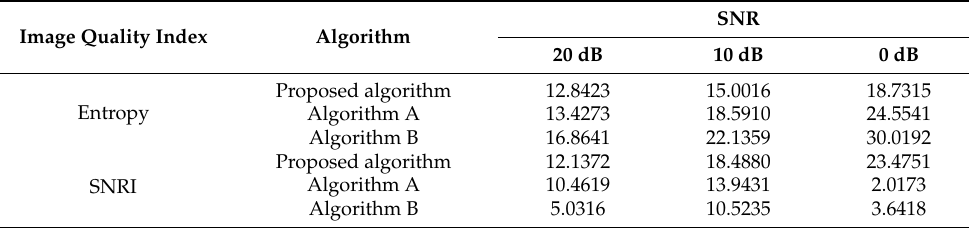
Figure 6. Simulation results 1: ( a ) imaging results under SNR = 0 dB; ( b ) imaging results under SNR = 0 dB; and ( c ) imaging results under SNR = 0 dB. Table 2. Experimental Results under different SNRs of scattering points.